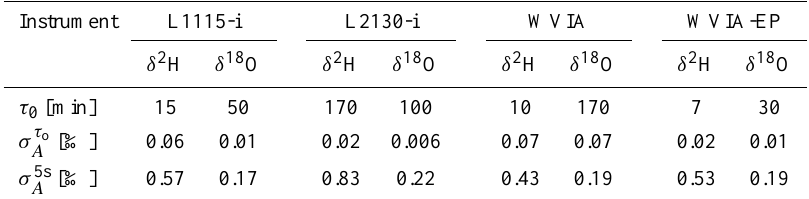
Table 7. Average response times in s and corresponding standard deviations for the L1115-i and the WVIA instrument and the differ- ent water isotopic species. In total 103 switching experiments were performed: 54 switches to higher water concentrations (switch up, τ up ) and 49 switches to lower concentrations (switch down, τ down ). Picarro WVIA τ up [s] τ down [s]